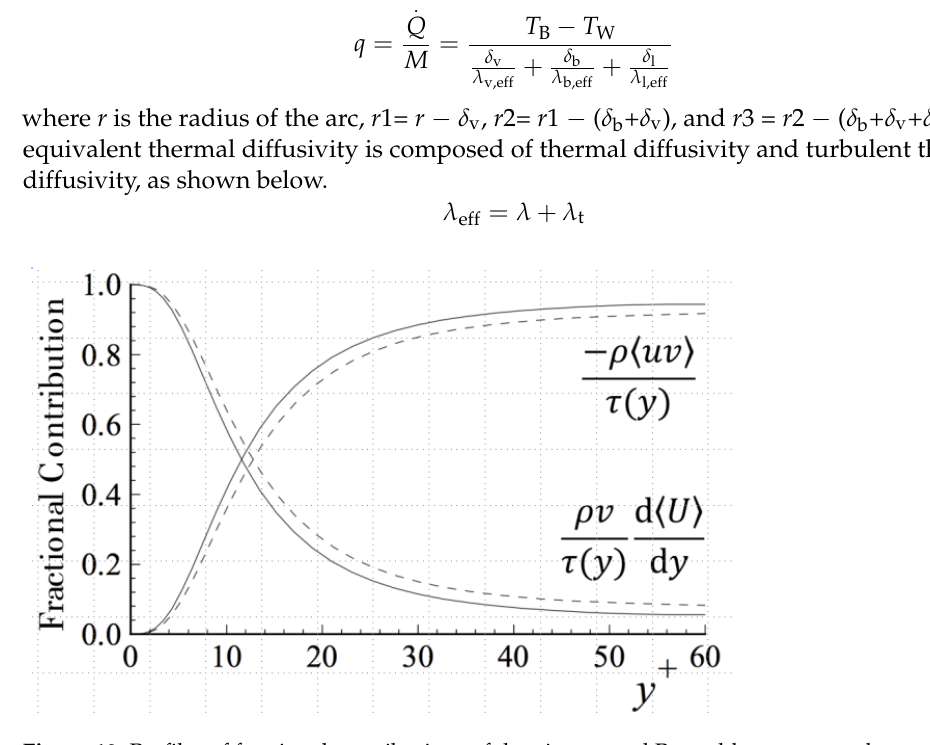
Figure 10. Profiles of fractional contributions of the viscous and Reynolds stresses to the total stress. The physical processes of Equations (21) and (22) are shown in Figure 11,